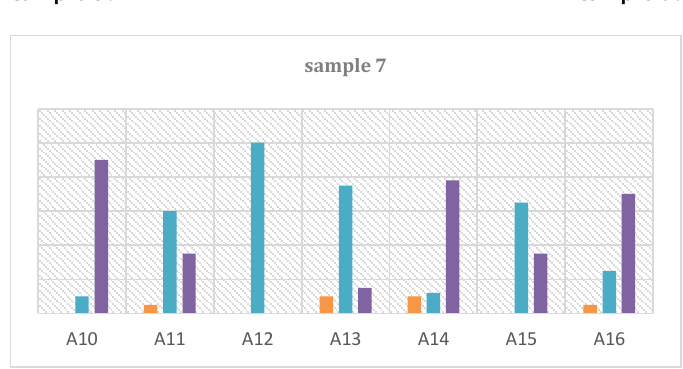
Fig. 14. The proportions of the questionnaire for sample 6.